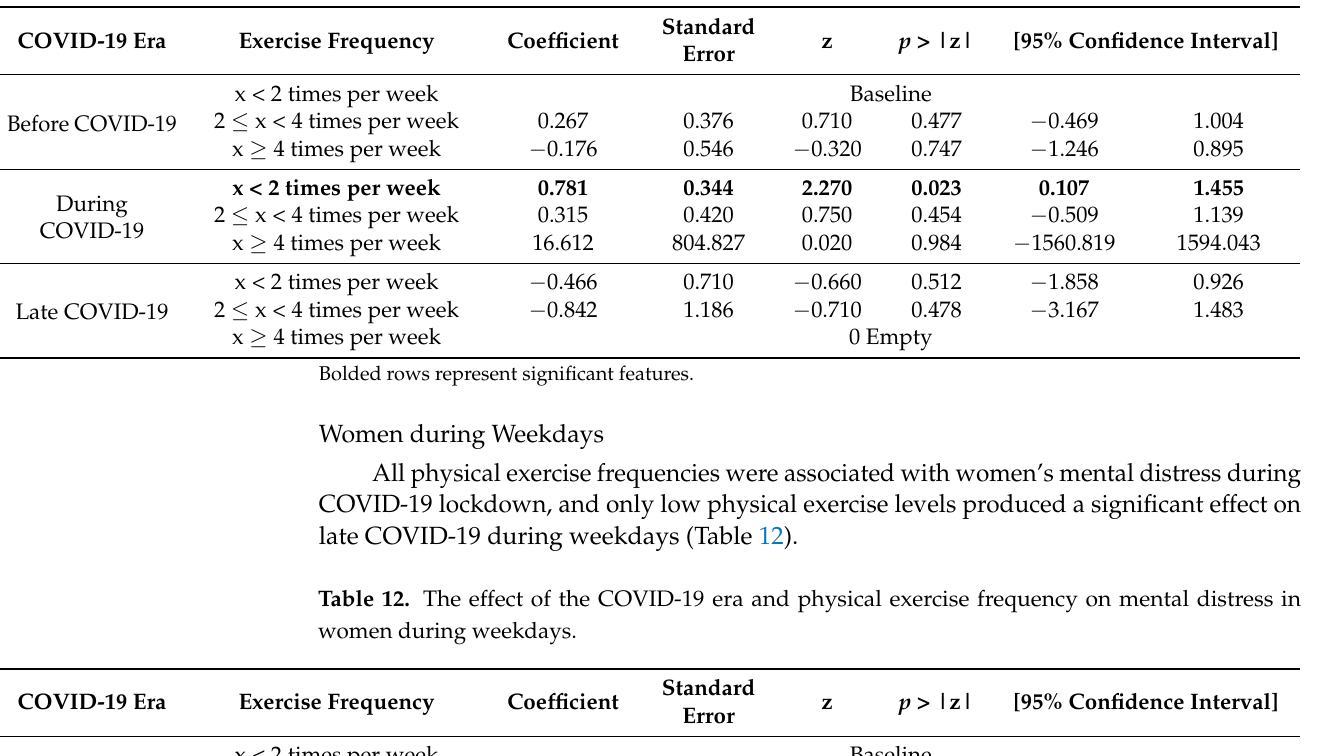
Table 11. The effect of COVID-19 era and physical exercise frequency on mental distress in women during weekends.